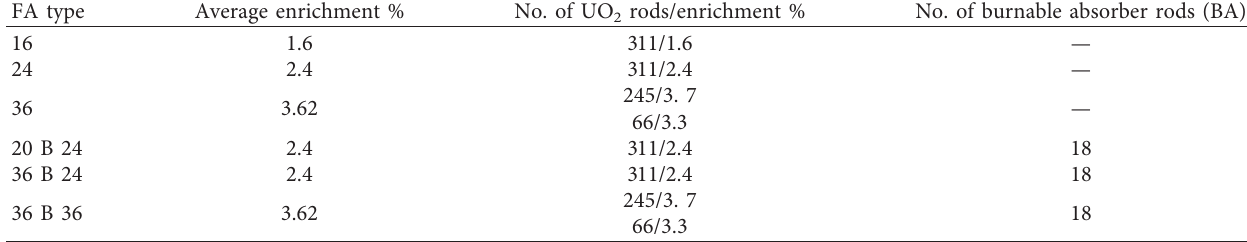
Table 2: FA types, enrichment, and number loaded in the core for the first operational cycle [12].